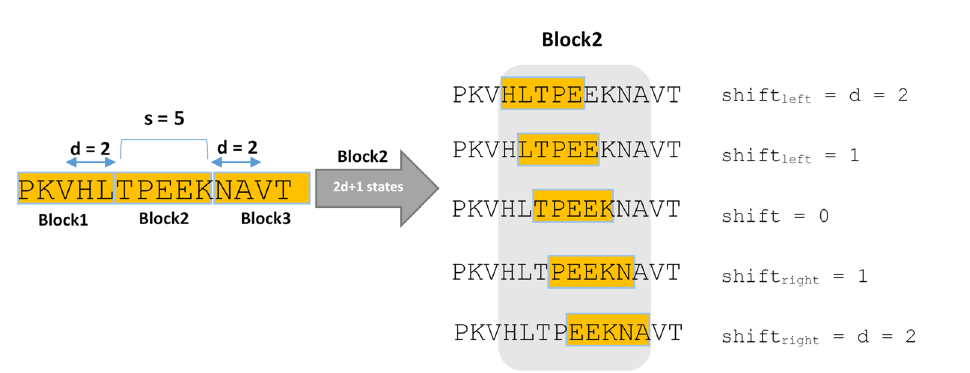
Figure 3. An example of sequence splitting into fixed size (S) blocks by various right and left shifts (d as maximum shift); in this example S = 5 and d =